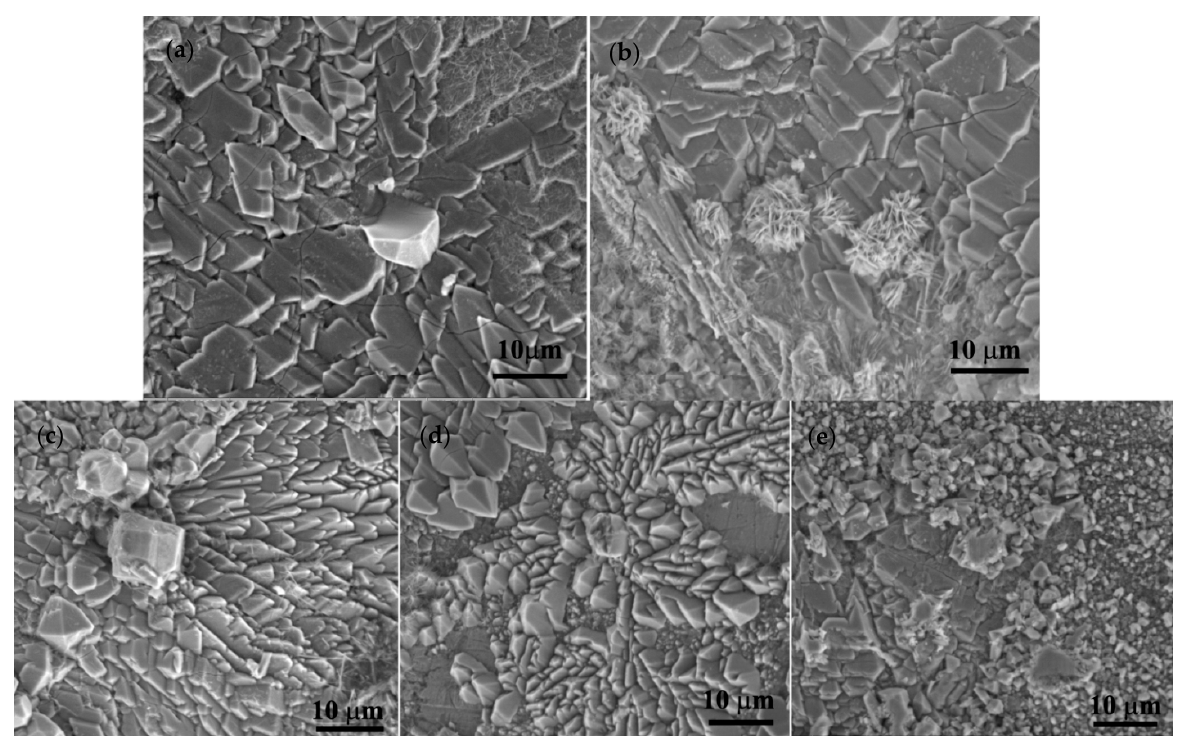
Figure 5. SEM after immersion period of three days and ultrasound cleaning: ( a ) Zn, ( b ) Zn 3 Mg, ( c ) ZnMg 0.4 Y, ( d ) ZnMg 0.5 Y, and ( e ) ZnMg 0.6 Y. Table 4. Chemical composition of the surface samples after immersion test (after 3 days and ultrasound cleaning).